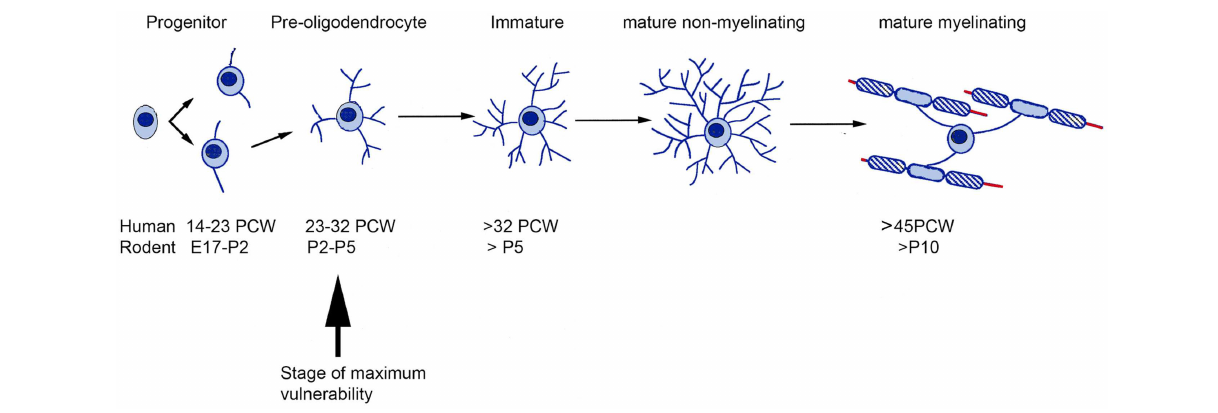
to disrupt glutamate homeostasis and inhibit glutamate transport in oligodendrocytes and astrocytes (29,